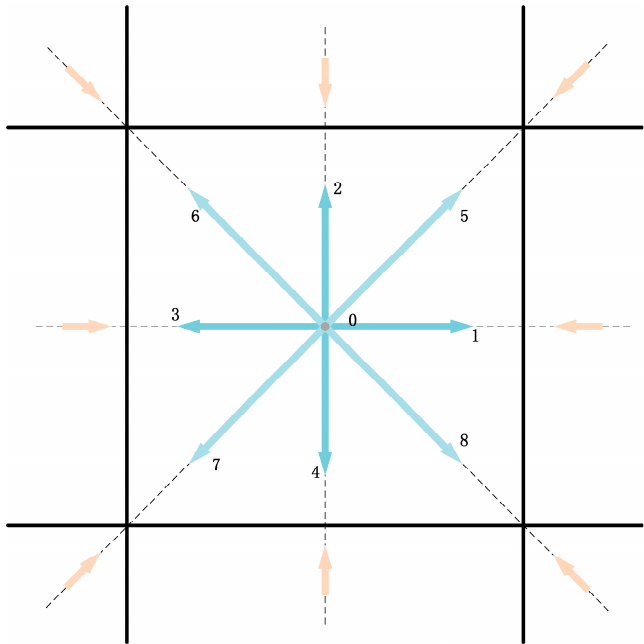
Figure 1. D2Q9 lattice model.